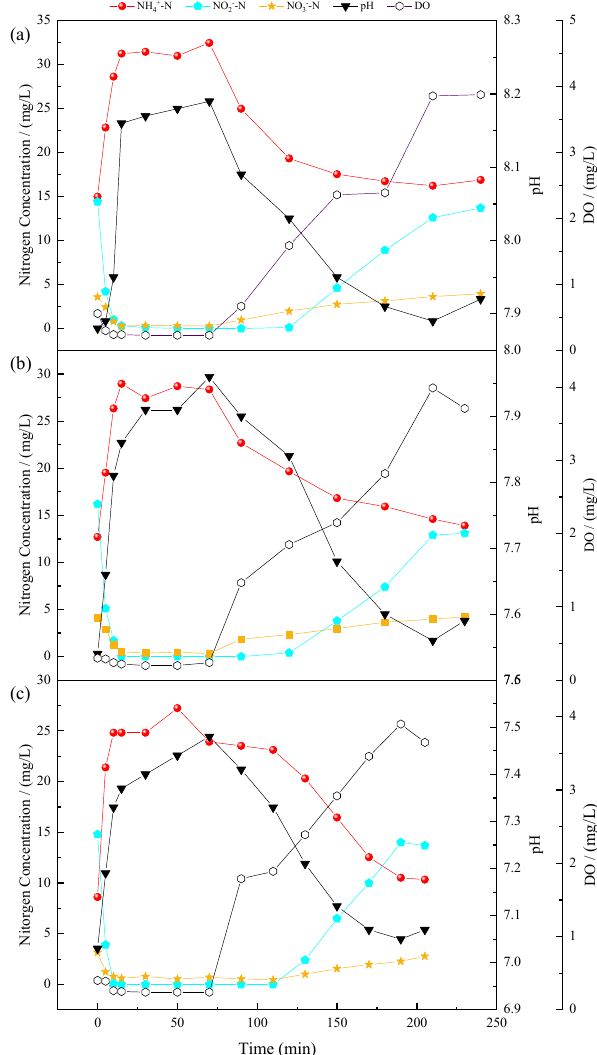
Figure 4. Evolution of nitrogen compounds during cycles in ( a ) Stage I, ( b ) Stage II, ( c ) Stage III.